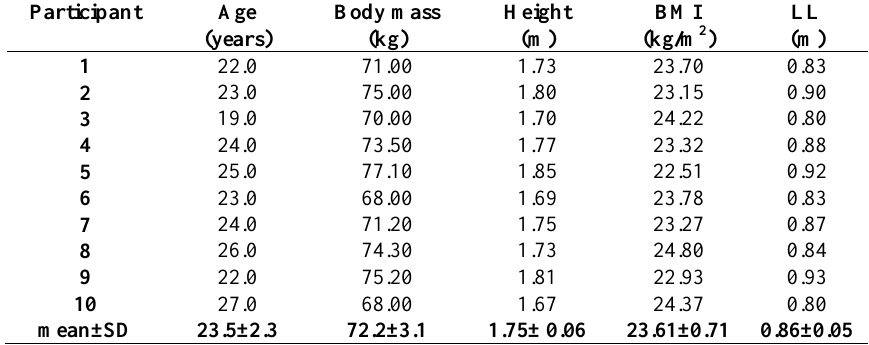
Table 1. Physical characteristics of the individuals who participated in the study. BMI (body mass index), LL (leg